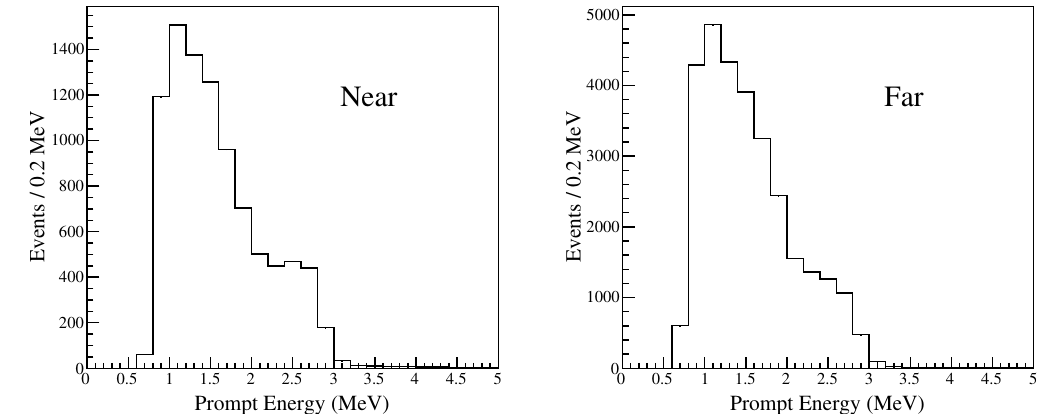
Figure 9 . Prompt energy spectra of accidental backgrounds. They are normalized to the remaining accidental backgrounds. The background rate of the far detector is (cid:24) 3 times higher than that of the near detector as expected from the higher radioactivity measured in the rock sample of the far site.